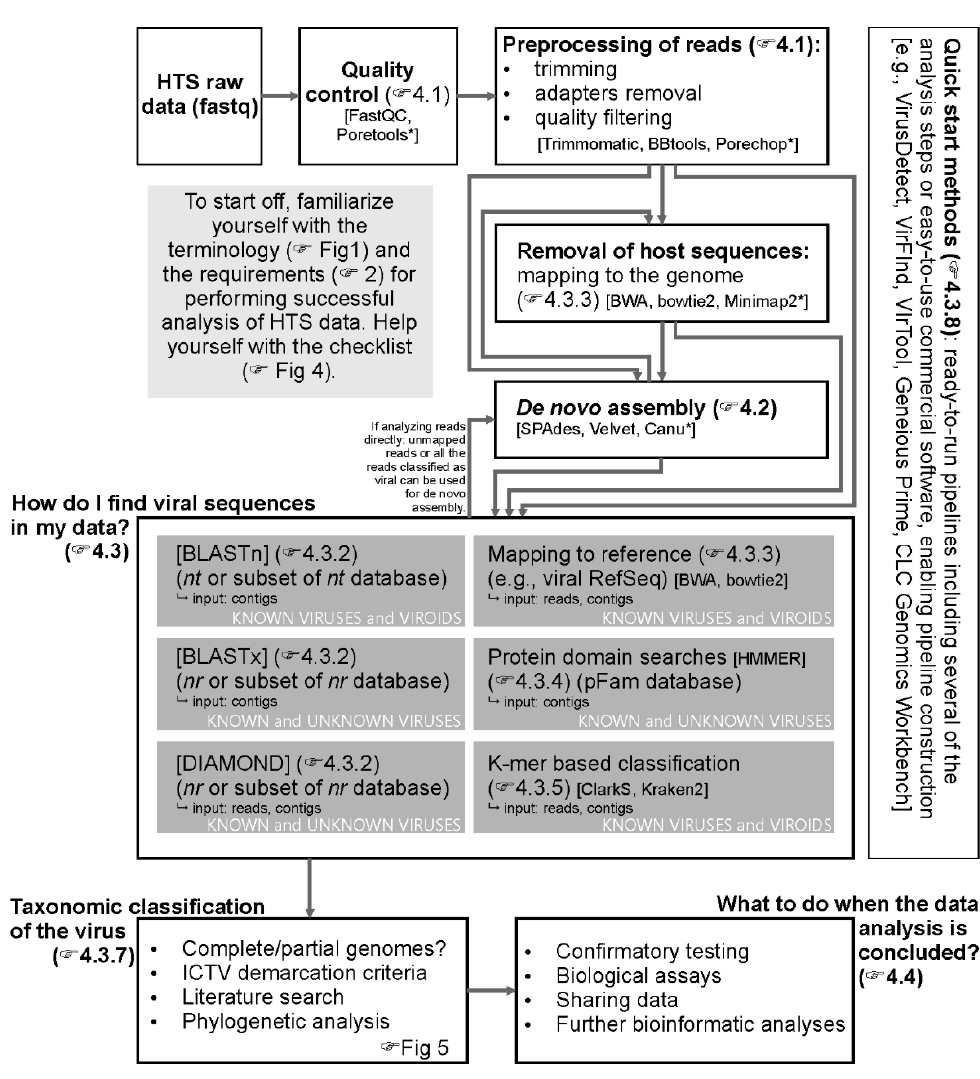
Figure 2. Flowchart representing different approaches for the analysis of HTS data for the detection of plant viruses. Boxes represent different steps in data analysis and interpretation. Arrows connect different possible sequences of the analysis steps. As an example, a non-exhaustive list of possible analysis tools is added in the square brackets at each of the analysis steps. Tools designated with * are intended for use with long-read or, specifically, nanopore sequencing data. Pointing hands lead to the text sections (or figures) with more detailed description of the corresponding steps.